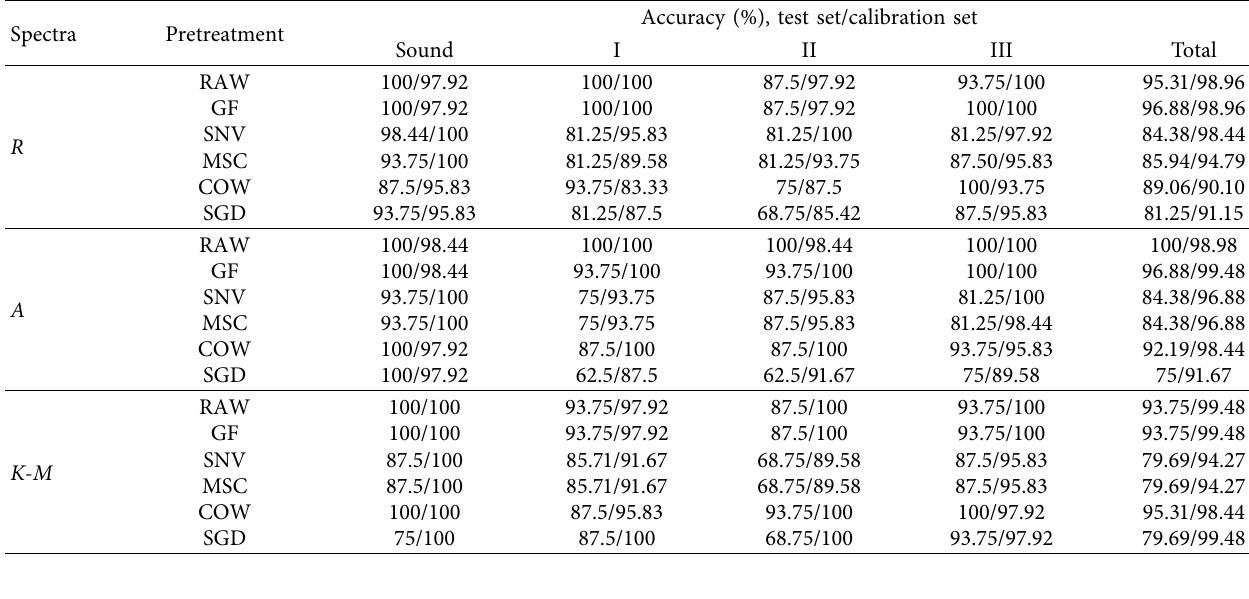
Table 2: Discriminant accuracy of SVM models based on R , A, and K - M spectra. Spectra